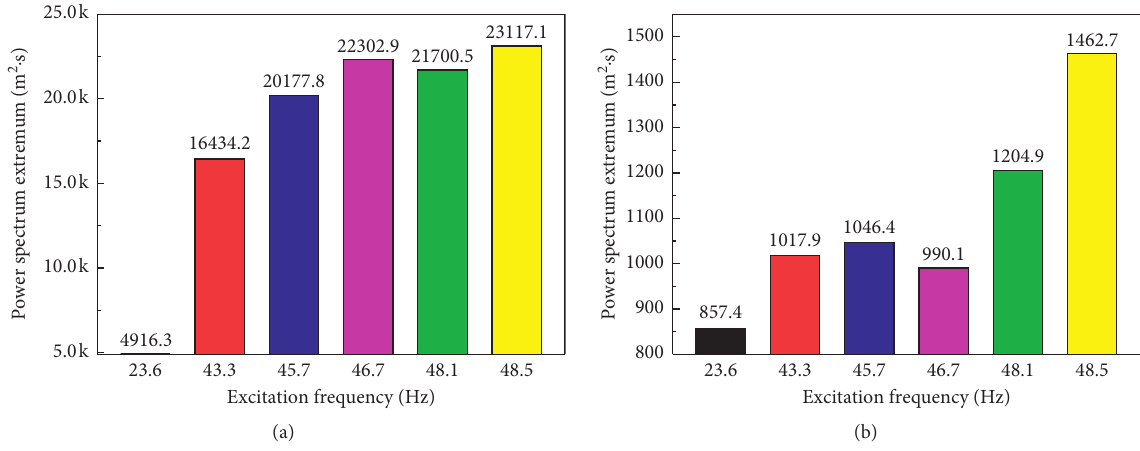
Figure 17: Maximum rope vibration power spectrum under different excitation frequencies. (a) Transverse. (b)